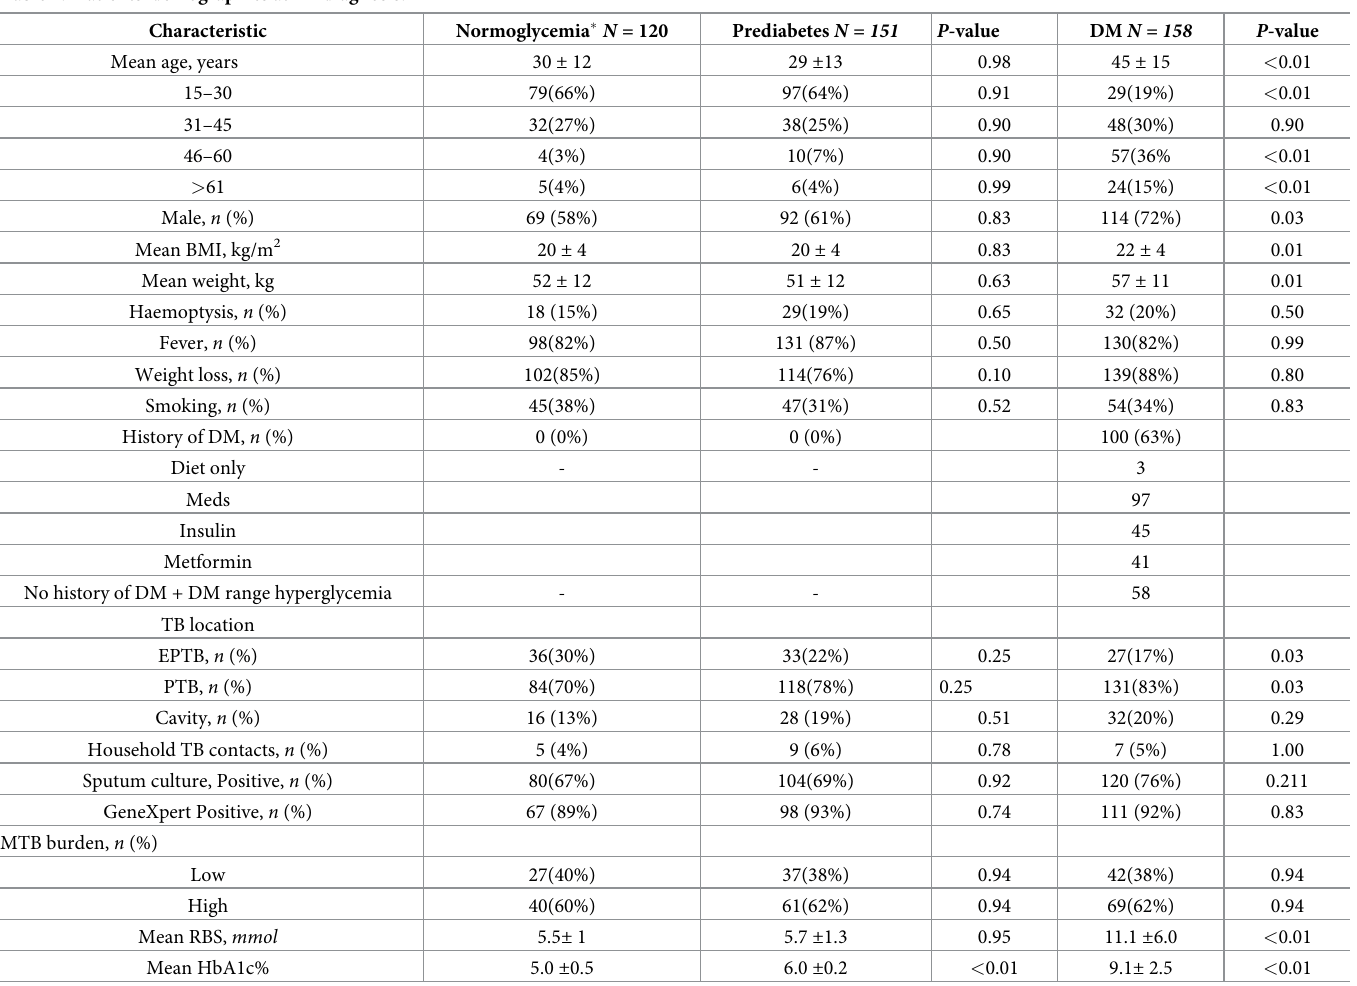
Table 1. Patients’ demographics at TB